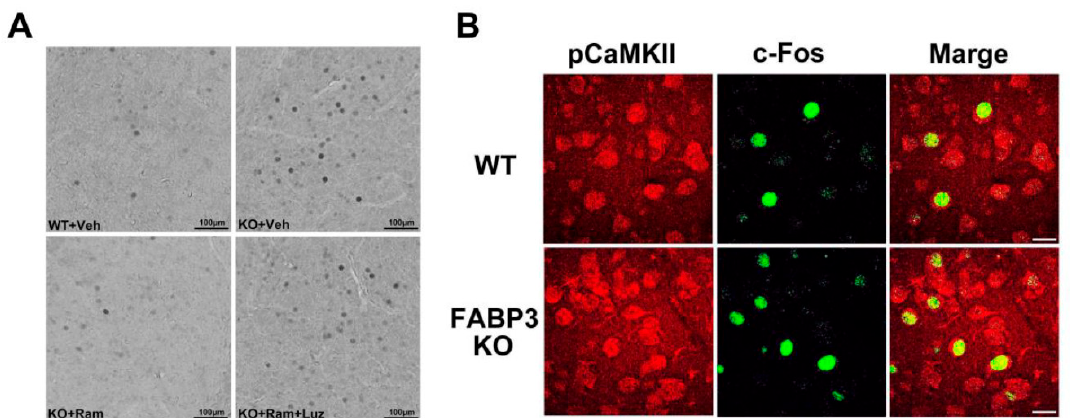
Figure 3. Aberrant c-Fos expression and CaMKII autophosphorylation levels in the basolateral amygdala (BLA) in Fabp3 null mice. ( A ) Representative images of BLA in each group of mice one hour after the extinction test on Day 35. The e ff ect of ramelteon (1.0 mg / kg, p.o.) on the elevated level of c-Fos was antagonized by luzindole (2.5 mg / kg, i.p.) treatment in Fabp3 null mice. Scale bars: 100 µ m. ( B ) Representative images of BLA in WT and Fabp3 null mice stained by phosphorylated CaMKII (red) and c-Fos (green). Increased c-Fos expression levels were observed in elevated autophosphorylation CaMKII-positive cells in BLA of Fabp3 null mice. Modified data derived from Reference